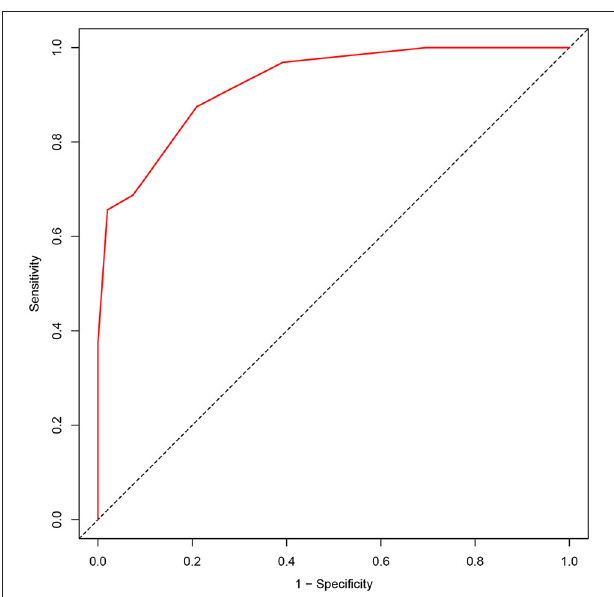
FIGURE 1 | ROC analyses of the APE 2 score. ROC, receiver operating characteristic.